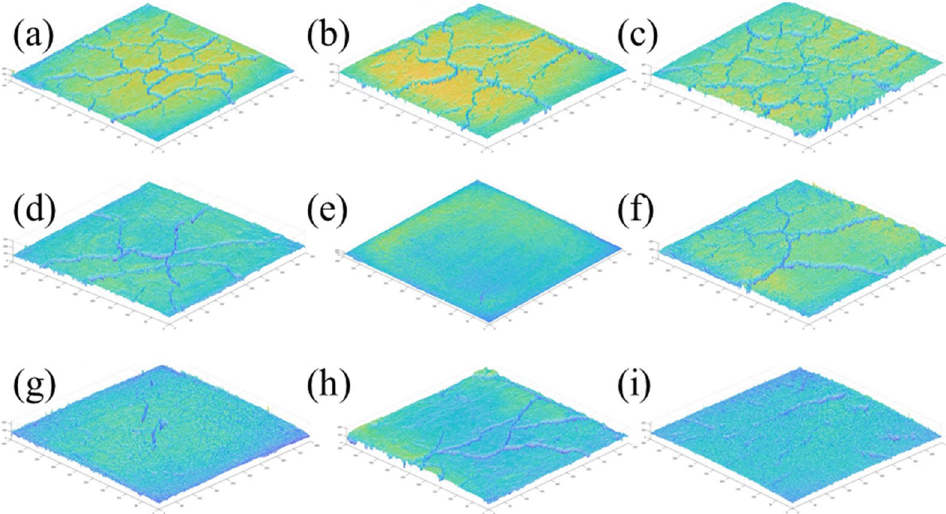
Figure 10. Pictures of freeze–thaw orthogonal test results. ( a ) A 1 B 1 D 1 , ( b ) A 1 B 2 D 2 , ( c ) A 1 B 3 D 3 , ( d ) A 2 B 2 D 3 , ( e ) A